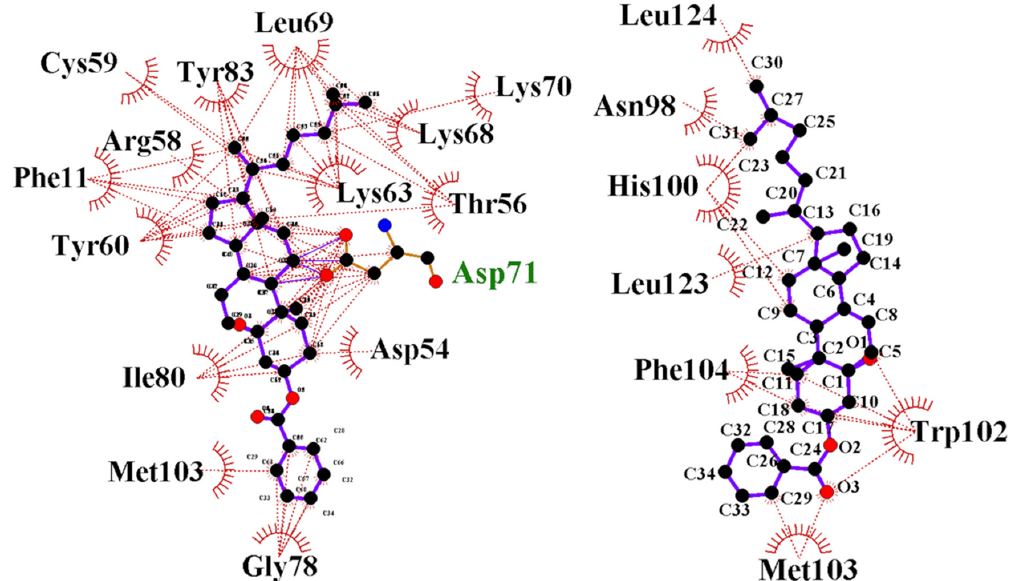
Figure 11. Interaction of the FAM72Awt-UNG2 (AA 1–45) heterodimer with withaferin B, another withanolide analog. ( Top left-hand side ): Schematic 3D interaction of FAM72A protein and UNG2 (AA 1–45) peptide heterodimer (cartoon model) with withaferin B (space-fill model) is shown. ( Top right-hand side ): FAM72A protein monomer (cartoon model) with withaferin B (space-fill model) is shown. ( Bottom left-hand side ): LIGPLOT output showing the interaction between the FAM72Awt-UNG2 (AA1–45) heterodimer and withaferin B. Green Asp71 indicates hydrogen bonding. ( Bottom right-hand side ): LIGPLOT output showing the interaction of FAM72Awt monomer with withaferin B. The binding affinity was calculated as − 1.868 kCal/Mol. Withaferin B, PubChem compound ID (CID): 11113907, molecular formula: C 34 H 50 O 3 , molecular weight: 506.8g/mol. IUPAC Name: [(1S,2R,5S,7S,9R,11S,12S,15R,16R)-2,16-dimethyl-15-[(2R)-6-methylheptan-2-yl]-8-oxapentacyclo [9.7.0.0 2,7 . 07,9 .0 12,16 ] octadecan-5-yl] benzoate. UNG2 ′ AAs Tyr(Y)8 and Phe(F)11 are the most im-